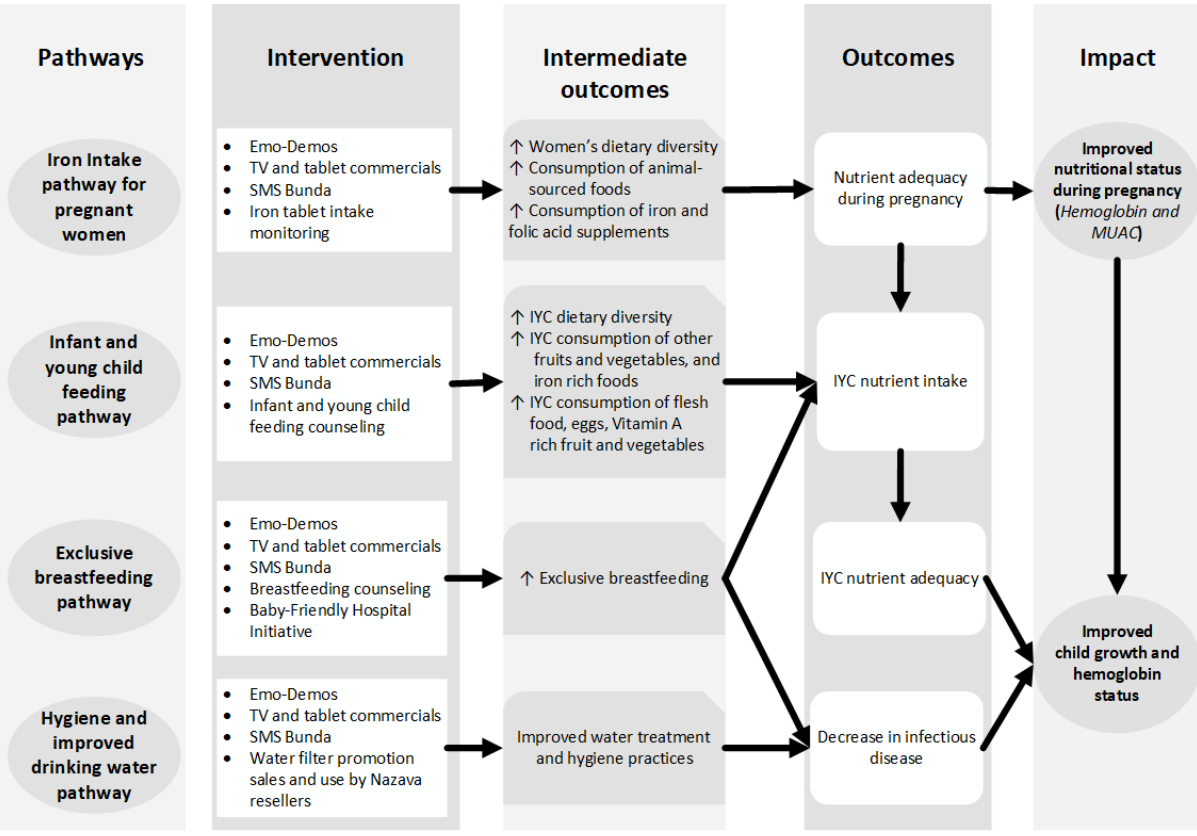
Figure 2. Impact pathways of the Baduta program interventions. IYC: infant and young child; TV: